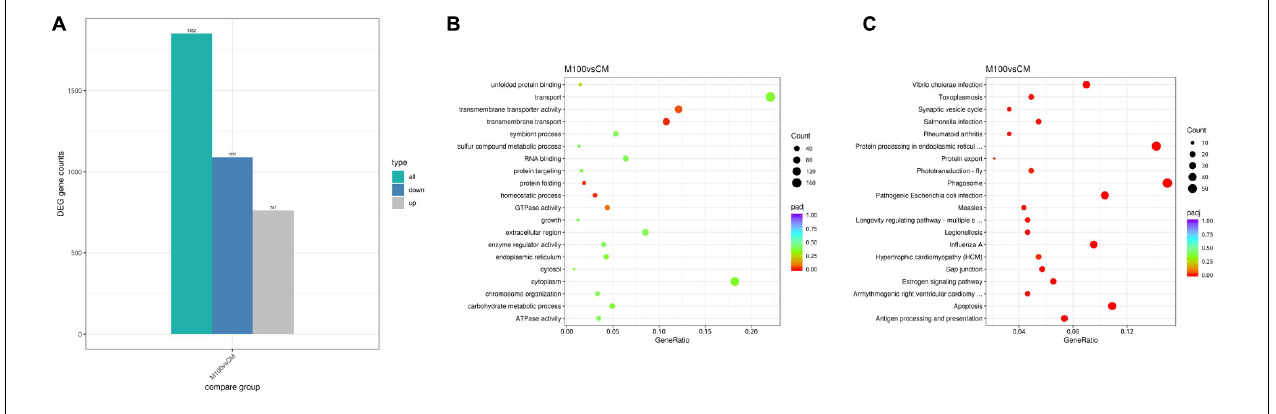
FIGURE 2 | (A) Differential expression of Exopalaemon carinicauda following Axn feeding. Significantly upregulated and downregulated genes are, respectively, shown in blue and gray. (B) The most enriched Gene Ontology (GO) term analysis and function classifications of the transcriptomic responses for Exopalaemon carinicauda after feeding Axn. (C) Kyoto Encyclopedia of Genes and Genomes pathway analysis of the transcriptomic responses for E. carinicauda after feeding Axn.